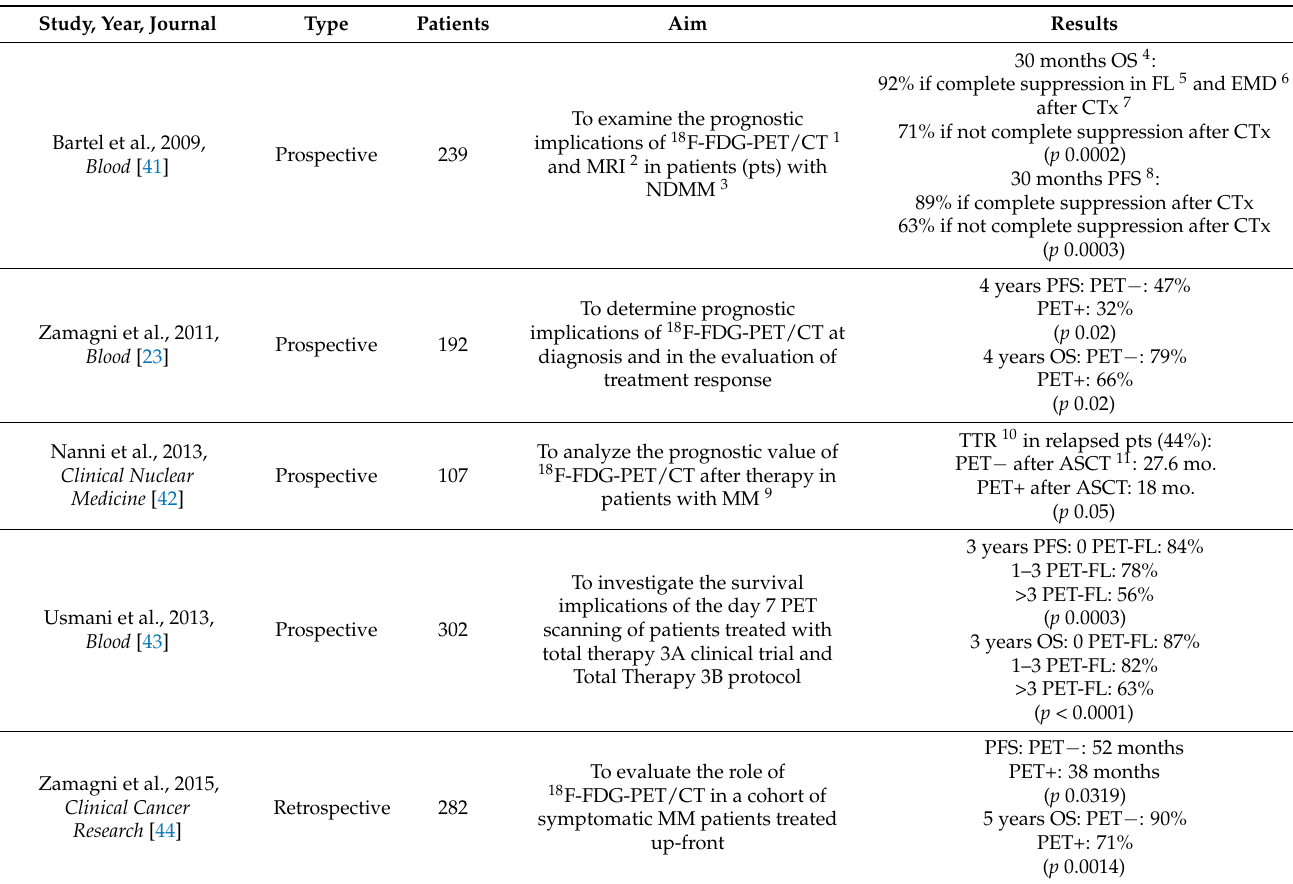
Table 1. Main studies assessing the performance of 18 F-FDG-PET/CT for treatment response in MM